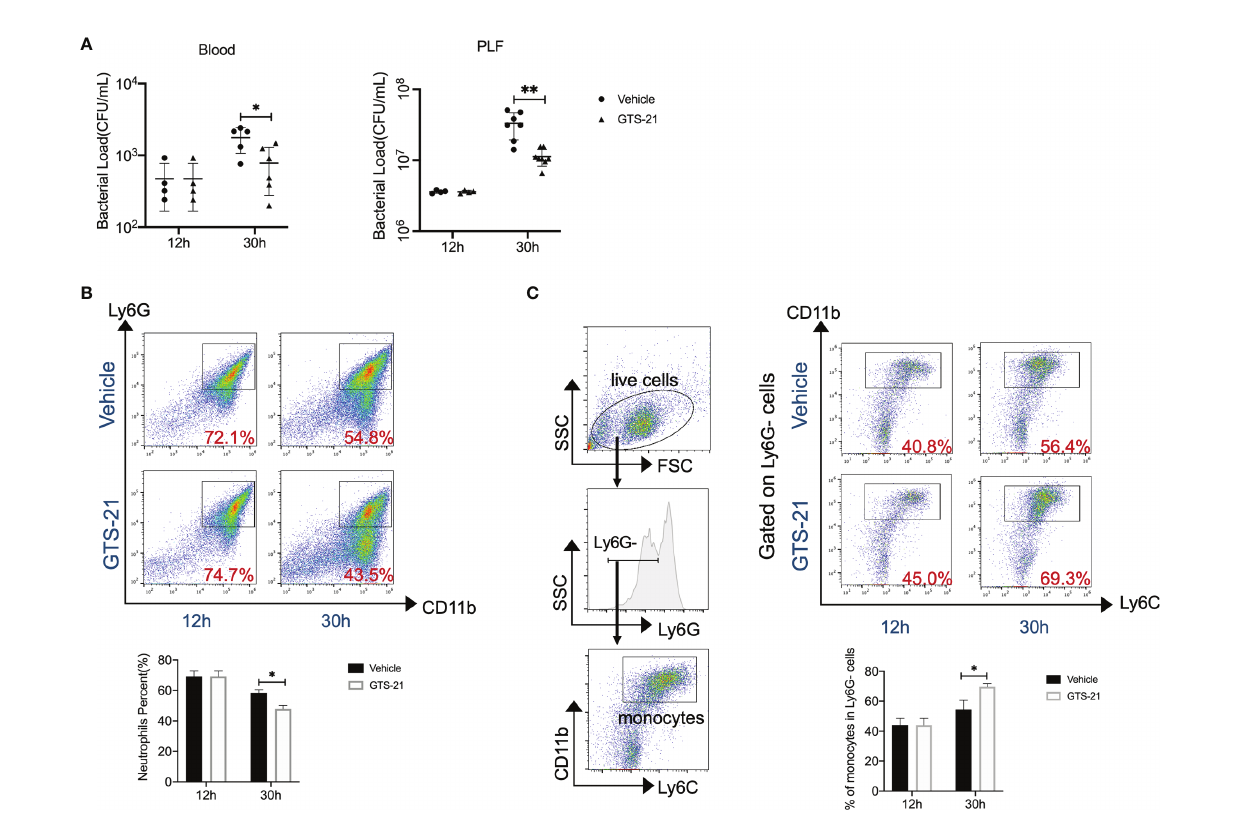
FIGURE 2 | GTS-21 treatment improves bacterial clearance and enhances monocytes ’ recruitment during CLP-induced septic peritonitis. Mice were subjected to CLP, and GTS-21 or vehicle was injected intraperitoneally 12h after CLP procedure and repeated every 12h. Then, GTS-21 or vehicle-treated mice were sacri fi ced at 12 and 30h after the CLP procedure. (A) PLF and peripheral blood were collected ( n =6~8 mice/group) and bacterial CFUs were determined. The horizontal bar represents the mean for each group. Symbols represent individual mice. (B, C) Peritoneal cells were harvested ( n =6~8 mice/group) and stained for neutrophils marker (CD11b+Ly6G+) or monocytes markers (CD11b+Ly6G-Ly6C+) respectively. Percentages of neutrophils or monocytes were measured by fl ow cytometry. Results are expressed as mean ± SEM. * p < 0.05; ** p < 0.01 for GTS-21 vs